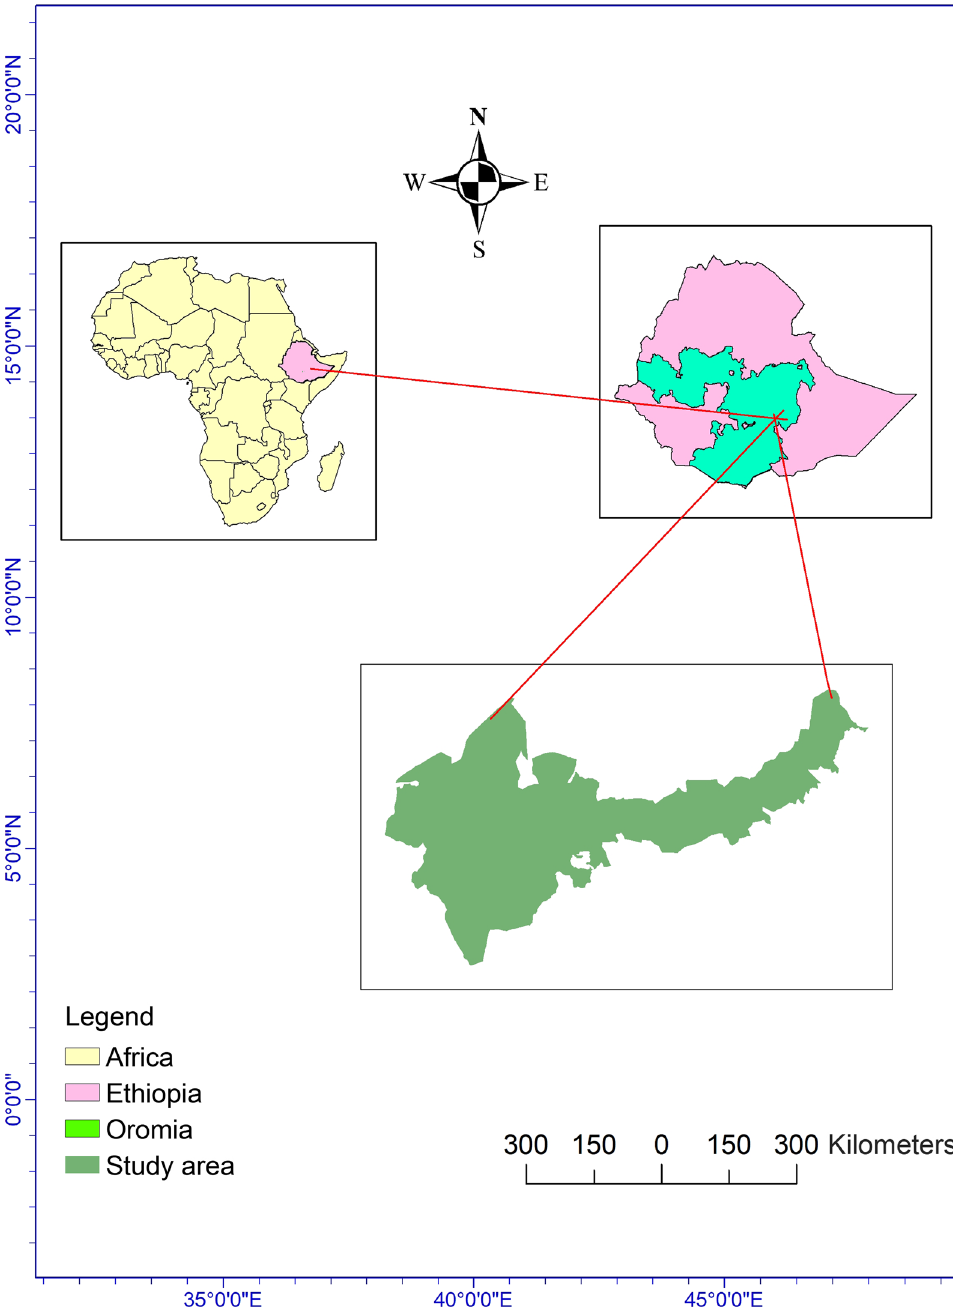
Fig. 1 Map of the study area in relation to the bigger geographical